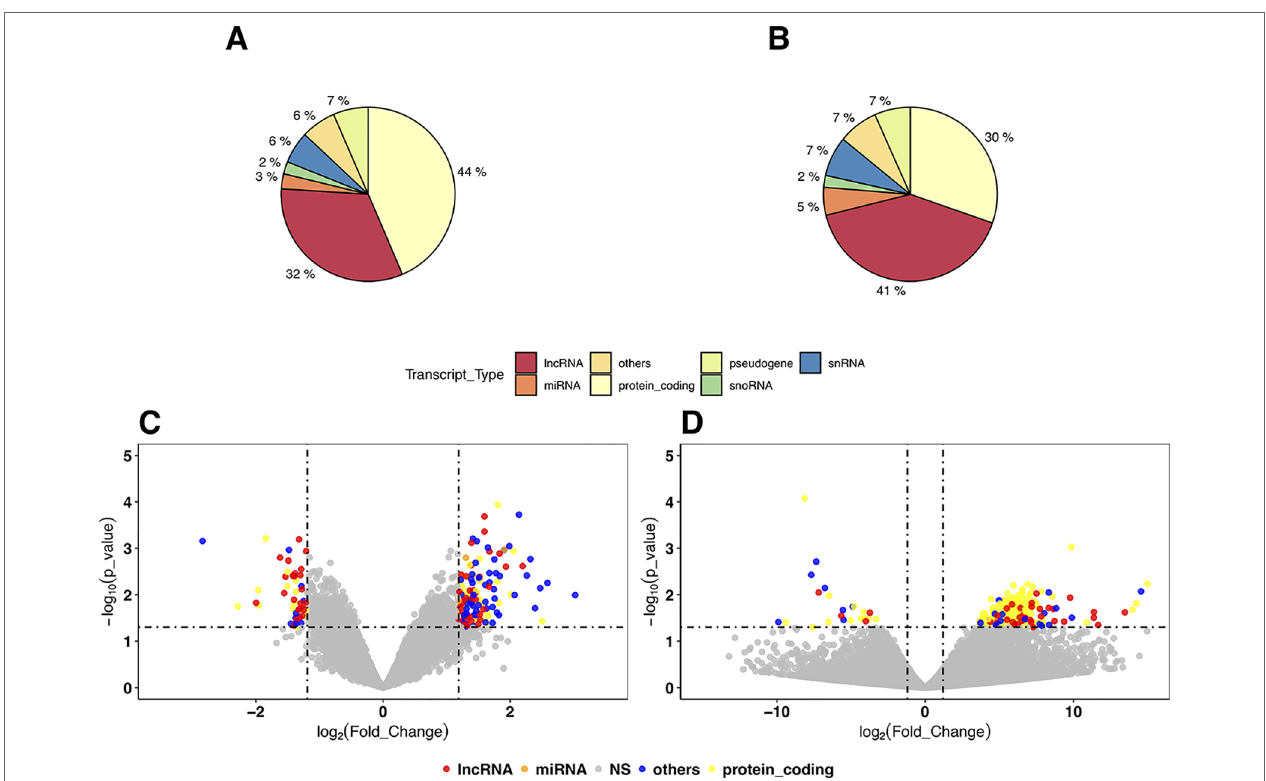
FIGURE 1 | The distribution and volcano plot of differentially expressed genes (DEGs). The color in all cells: blue for protein coding genes, pink for long noncoding RNAs (lncRNAs), green for microRNAs, and purple for other RNA genes (small nuclear RNAs, ribosomal RNAs, small noncoding RNAs, etc). (A) The distribution of DEGs in the discovery samples with Human Transcriptome Array (HTA) 2.0. (B) The distribution of DEGs in mega-analysis of all microarray samples. (C) The volcano plot of mega-analysis of all microarray samples. (D) The volcano plot of RNA sequencing (RNA-Seq)